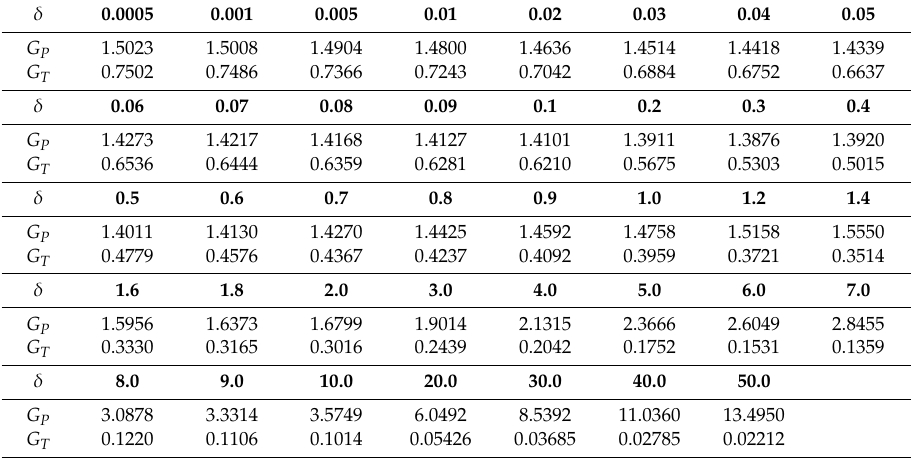
Table A1. Kinetic coe ffi cients G P and G T for the pressure- and temperature-driven flows, respectively, in terms of the gas rarefaction parameter δ